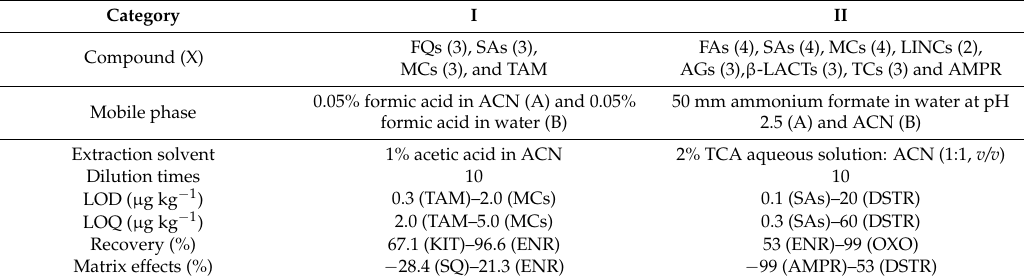
Figure 5. Comparison of the amount of 10 analytes in medicated chickens ( A ) No. 2, ( B ) No. 3 obtained by using the proposed method and the method in literature ( n = 6). Method I, the method reported in the literature. Method II, the proposed method. Table 4. Comparison of the proposed method with the method reported in the literature.